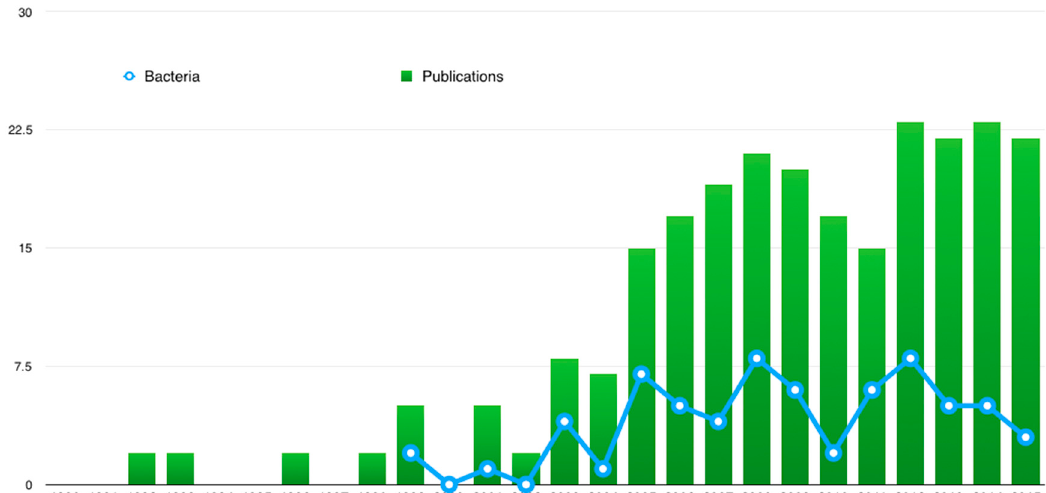
Figure 1. Publishing trends with “dielectrophoresis” and “impedance” keywords in Web of Science from 1990 to 2015. Blue line indicates the same keywords plus “bacteria”.